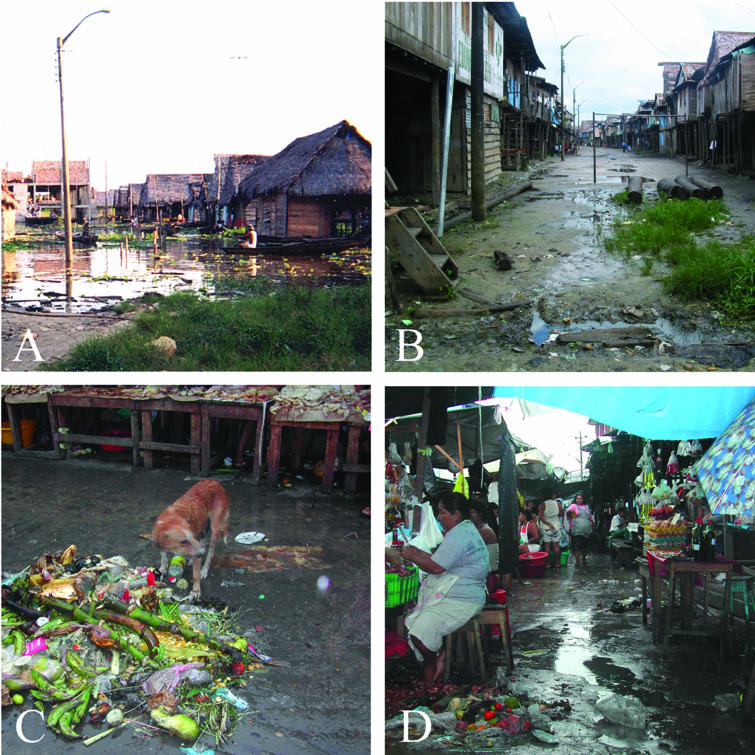
The Urban Slum Environment of the Belen District of Iquitos(A and B) Typical houses in the Belen district, built on stilts to avoid flood waters when the river rises.(C) Typical “sanitation” in the Belen Market area that attracts scavenger animals such as dogs and rats.(D) A typical view of the Belen Market area where commerce is conducted. Rats are often seen beneath tables and in gutters. Rats are so abundant in the market areas that they are commonly seen during the day although they are primarily nocturnal.(With kind permission of Springer Science and Business Media)